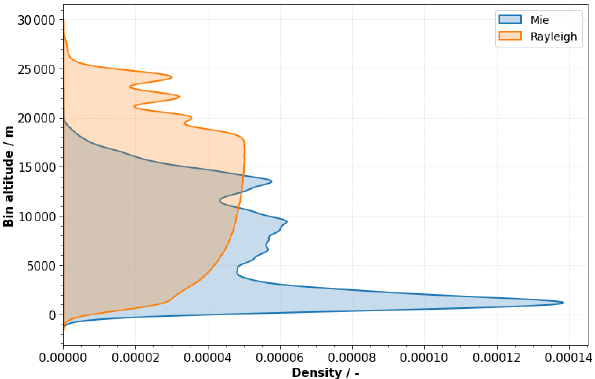
Figure 3. Density curves of the center-of-gravity altitudes of the Mie cloudy (blue) and Rayleigh clear (orange) L2B wind results. A total of 74202 Mie and 132042 Rayleigh wind results obtained from 8 August 2019 were used to derive the probability density curves. Only valid wind results with HLOS error estimates smaller than 4 and 8ms − 1 for the Mie and Rayleigh channels, respectively, are